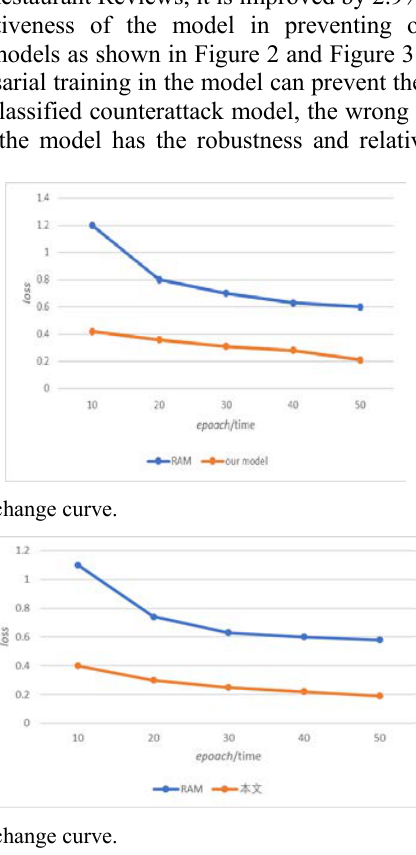
Fig. 3. Loss function value change